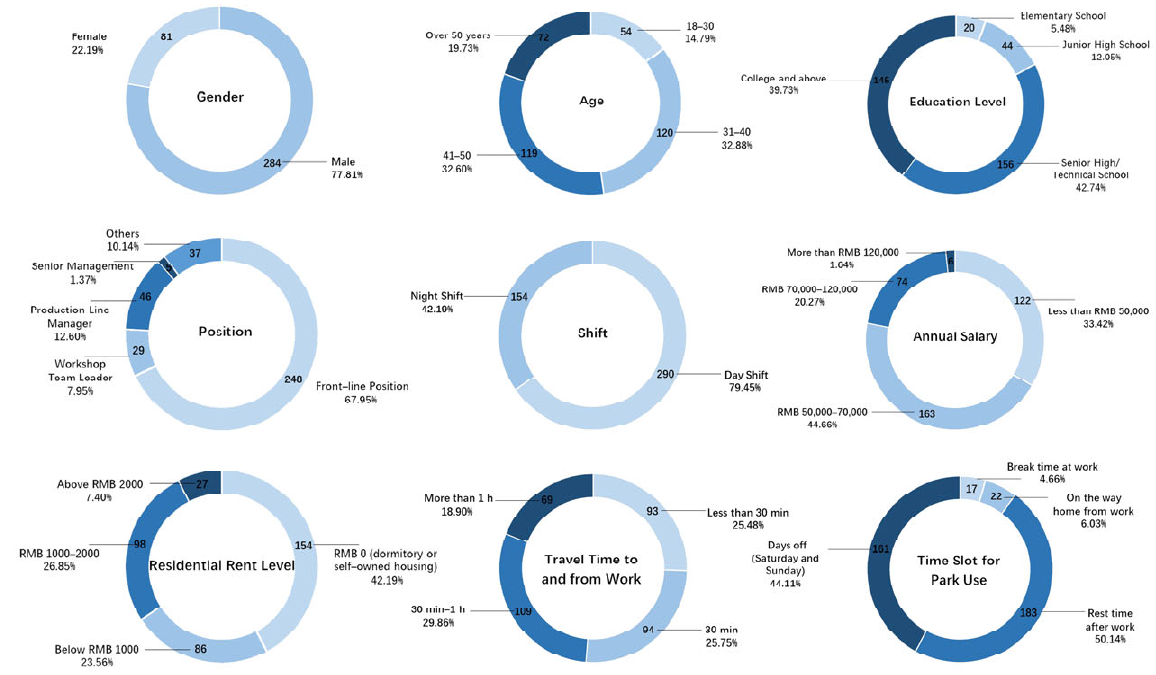
Figure 4. Sample structure of respondents.